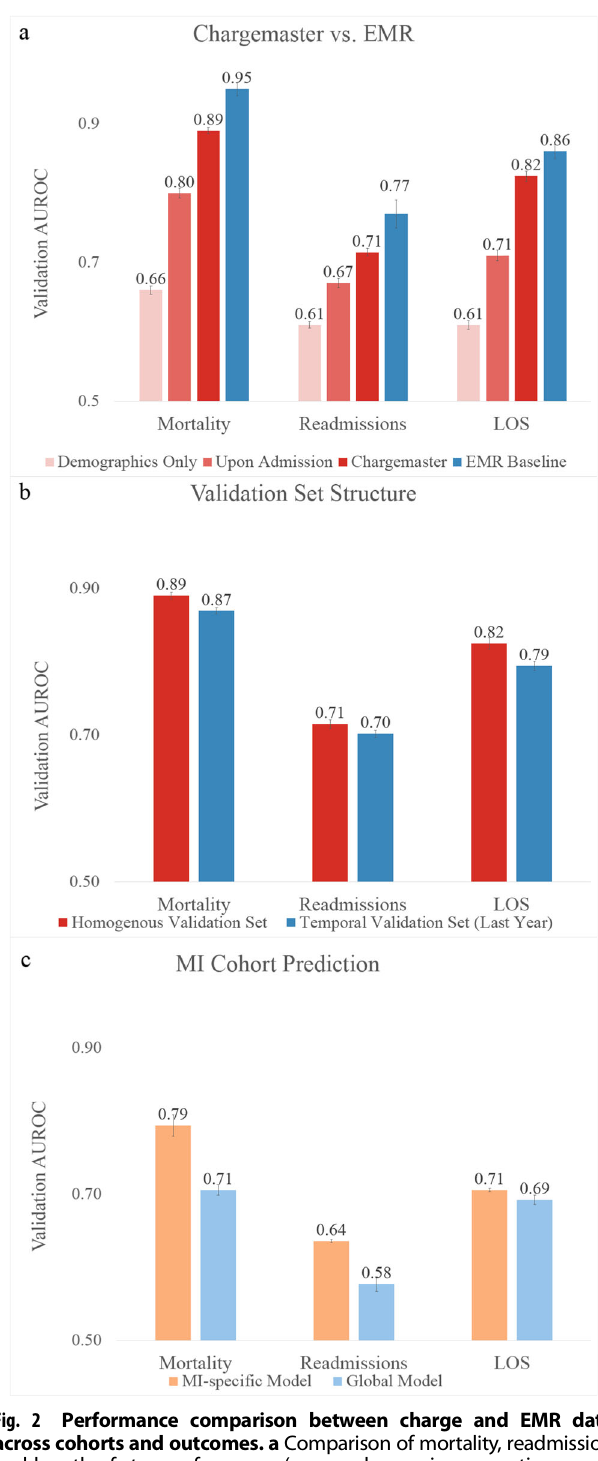
Fig. 2 Performance comparison between charge and EMR data across cohorts and outcomes. a Comparison of mortality, readmission and length of stay performance (area under receiver-operating curve, AUROC) on randomly selected validation data. b Average relative features per patient for each model version. c Outcome comparison on a myocardial infarction (MI) patient cohort between models trained on MI patients exclusively and all available model trained generally to “ guess ” at a clinician ’ s thinking may be less effective when required to work across contexts, as the range of mechanisms that must be inferred is much wider.